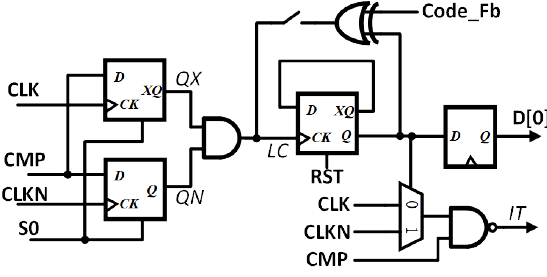
Figure 14. Modified DDR Cell for gain-adaptive